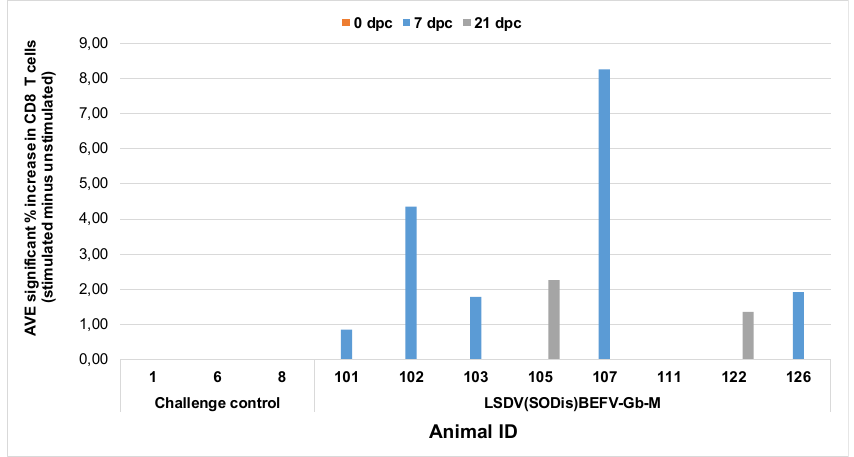
Figure 11. CD8 + T cell responses to BEFV following virulent LSDV challenge. Whole blood was stimulated with BEFV for 24 h and CD8 + T cells were measured. Only significant average % CD8 + T cells compared to control stimulants are shown. Animals 1, 6 and 8 were naïve control animals; animals 101, 102, 103, 105, 107, 111, 122 and 126 were all vaccinated with LSDV(SODis)BEFV-Gb-M. None of the animals vaccinated with LSDV( ∆ SOD)BEFV-Gb-M gave positive responses and there were no positive responses at 0 dpc. dpc = days post challenge.